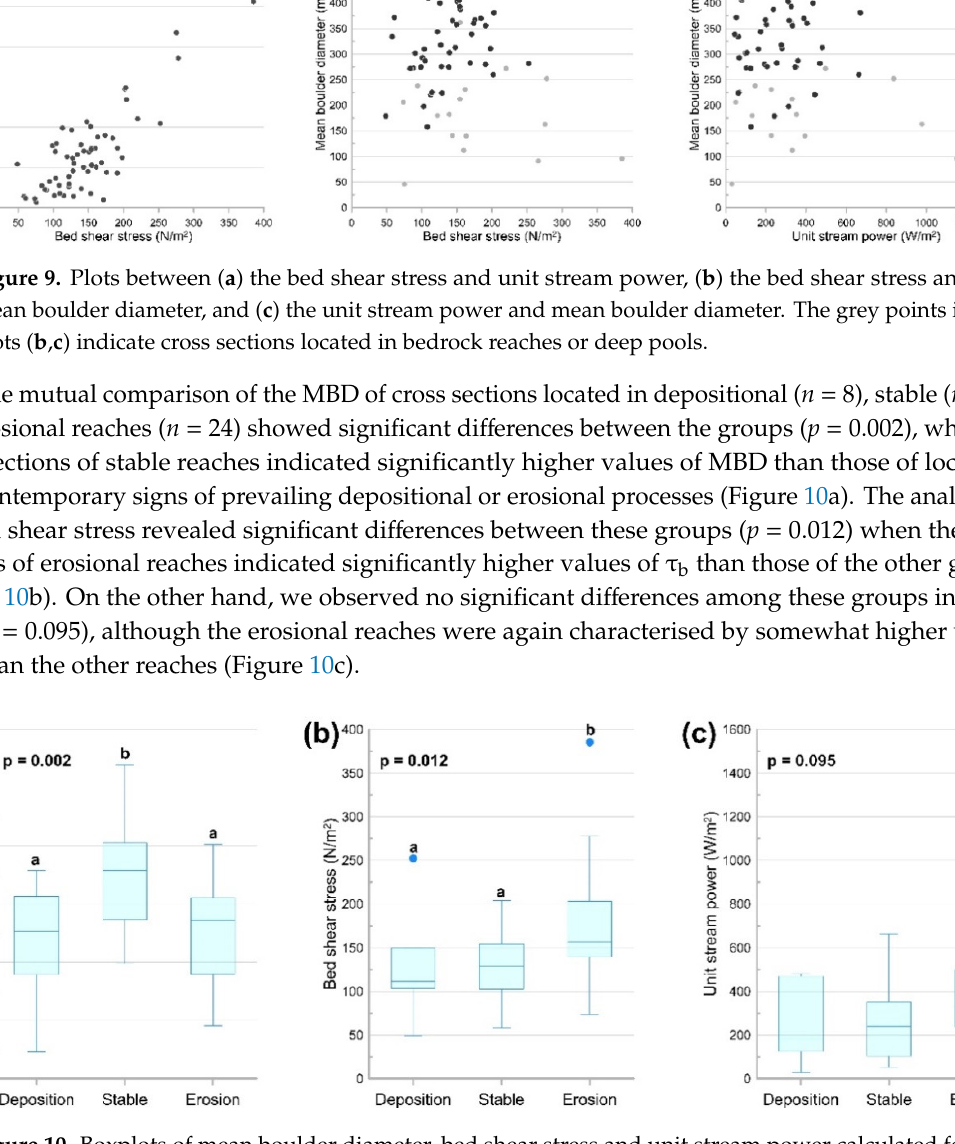
Figure 9. Plots between ( a ) the bed shear stress and unit stream power, ( b ) the bed shear stress and mean boulder diameter, and ( c ) the unit stream power and mean boulder diameter. The grey points in plots ( b ) and ( c ) indicate cross sections located in bedrock reaches or deep pools.